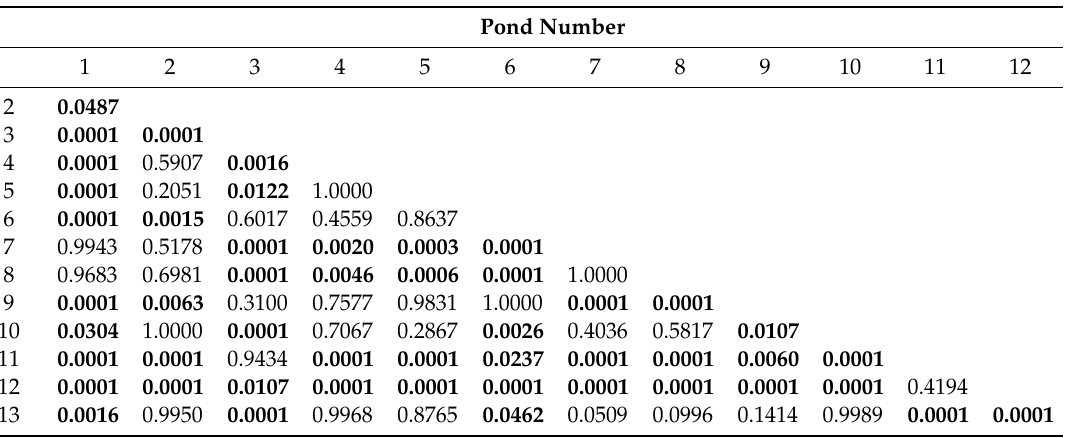
Table 3. ANOVA analysis: F = 36.906, p < 0.0001 ( p -values determined for area of ponds). Pond